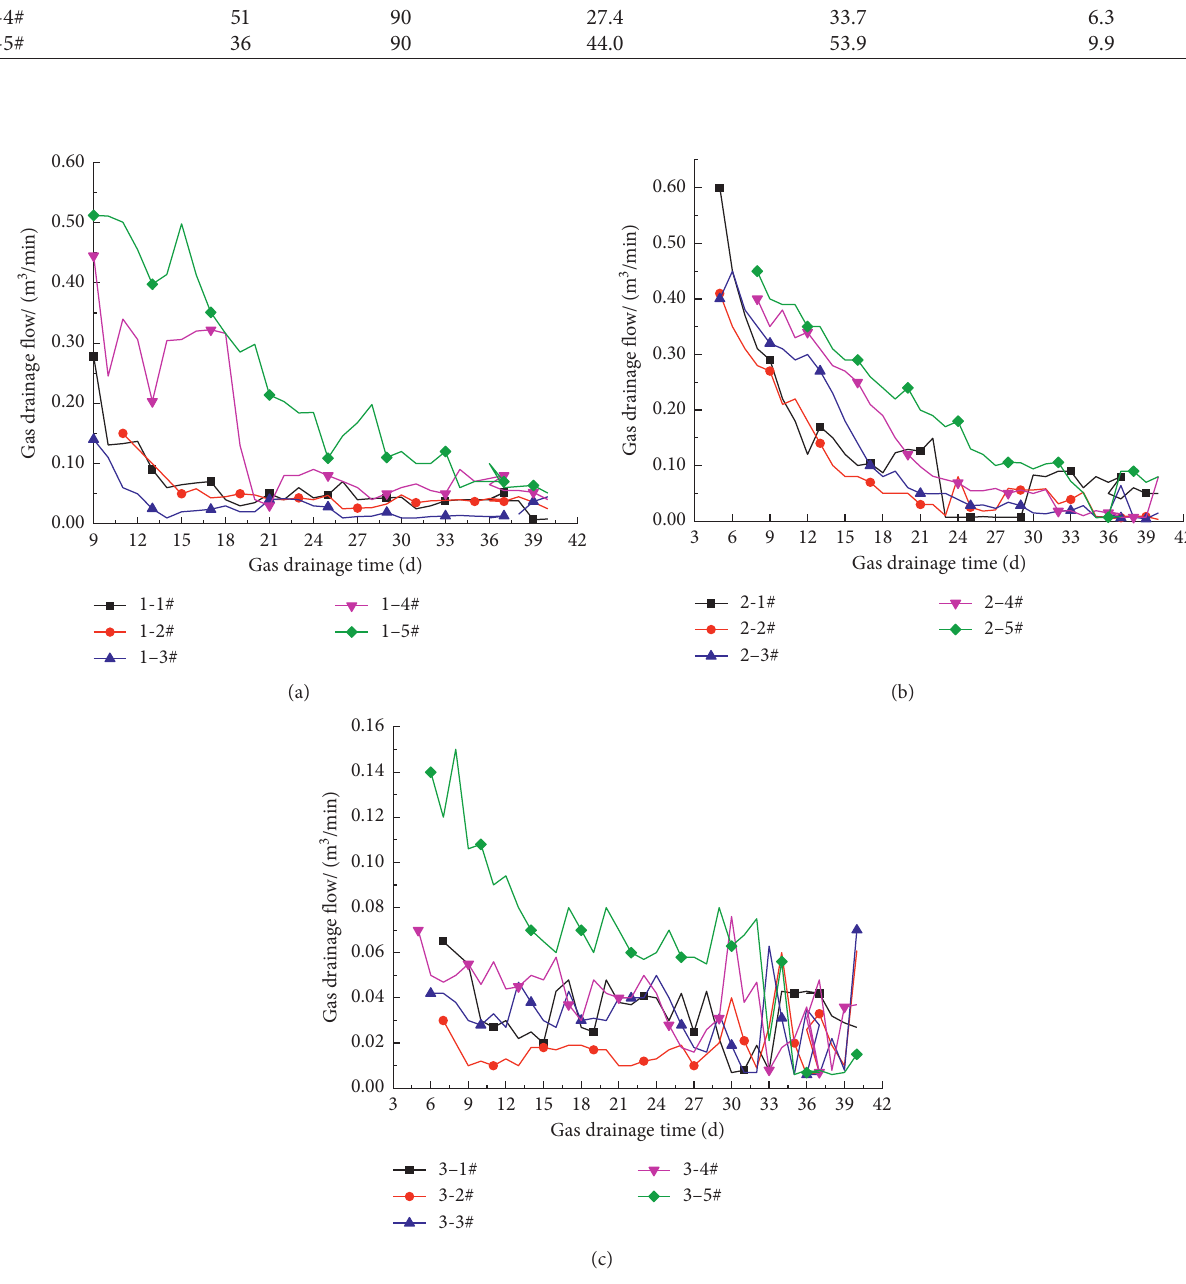
Figure 5: Three groups of borehole drainage gas flow attenuation quantity. (a) 1#, (b) 2#, and (c) 3#.